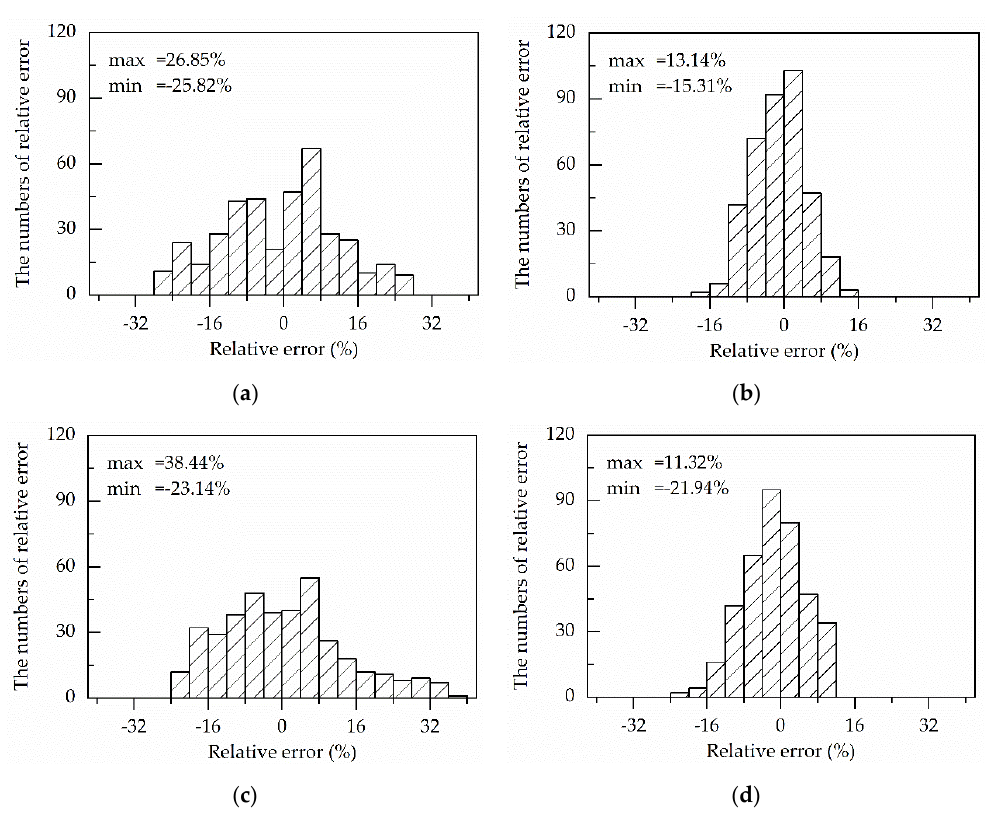
Figure 16. Statistical analysis of the relative error from ( a ) the original strain-compensated Arrhenius-type (os–cA-type) equation; ( b ) modified strain-compensated Arrhenius-type (ms–cA-type) equation; ( c ) original Hensel–Spittel (oHS) equation; ( d ) modified Hensel–Spittel (mHS) equation.